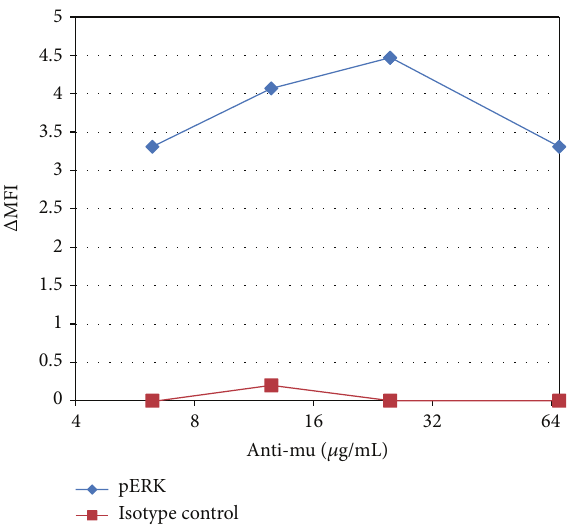
Figure 2: Change in pERK at 5 minutes after stimulation as a function of concentration of anti-mu used to stimulate the